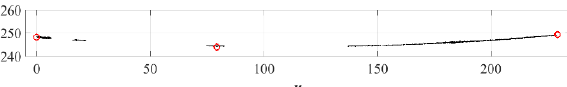
end of the segment and the third one having the lowest height, preferably located in the middle of the sag.